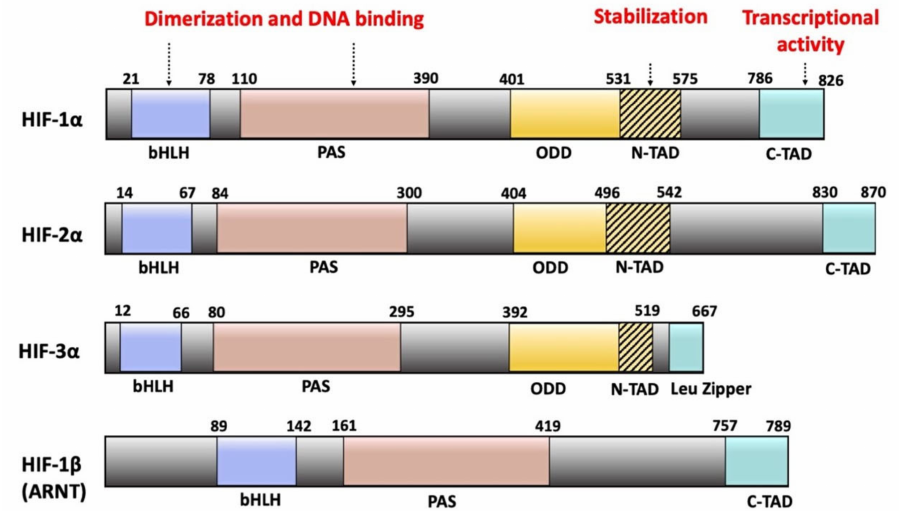
Figure 1. Domain architecture of HIF- α and HIF-1 β subunits. All subunits contain bHLH and twin PAS domains. These domains contain the DNA binding and heterodimerization sites. All three HIF- α forms possess an oxygen-dependent degradation (ODD) domain. HIF-1 α and HIF-2 α possess two transactivation domains (N-TAD and C-TAD). N-TAD is responsible for stabilizing all three forms of HIF- α under hypoxic conditions, while C-TAD controls the transcription of HIF- α target genes. The N-TAD domains are part of the ODD domains. HIF-3 α possesses a leucine zipper (LZIP) domain instead of a C-TAD domain. HIF-1 β lacks both the ODD and N-TAD domains. Structurally, all three HIF- α and the HIF-1 β subunits contain a basic helix-loop-helix (bHLH) and a twin Per-ARNT-Sim (PAS) domain in the N-terminal part of the protein. These domains are responsible for heterodimerization between the α and β